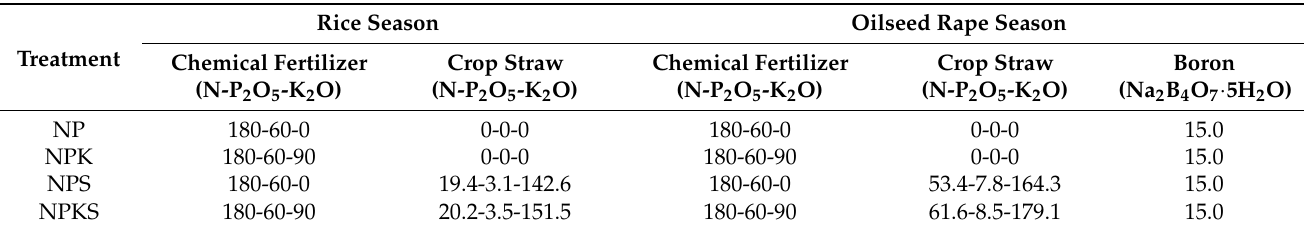
Table 1. The application rates of N, P, K, and B for treatments in both seasons per year from 2011 to 2020 (kg ha − 1 ).